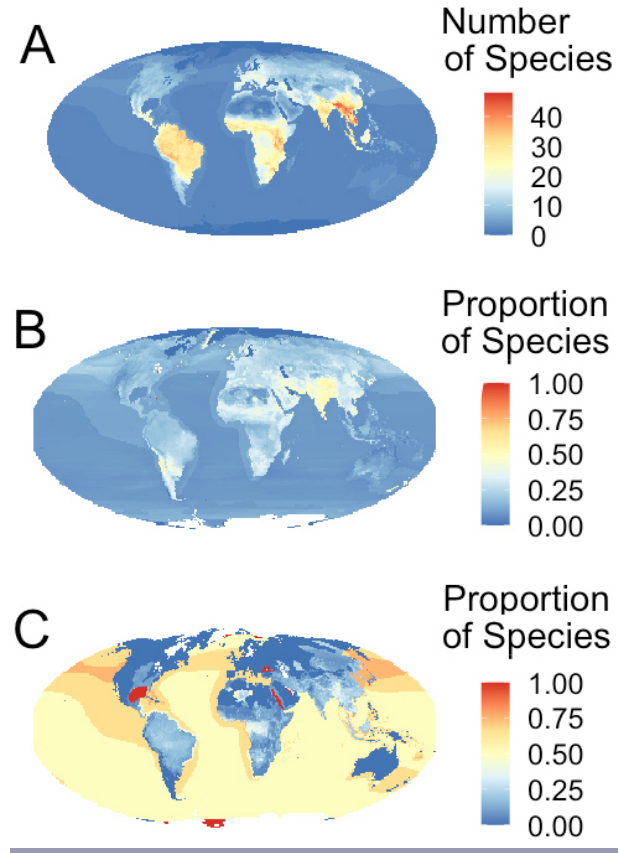
Fig. 4. Percentage of spiritual and nonspiritual use animals